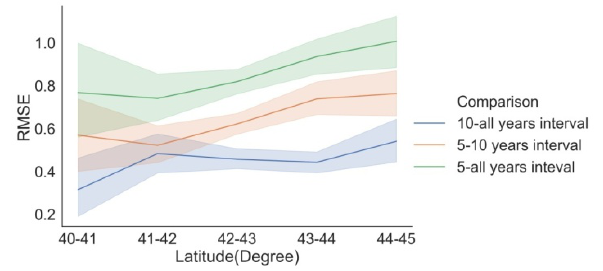
Figure 4. RMSE results in different time intervals Mean absolute difference (MAD) results in 5-10 years interval in Closed Shrublands during 41° and 42° had the minimum value with 1.65 days. MAD results in 5-all years interval in Mixed Forests during 44° and 45° had the maximum value with 9.57 days. Areas with MAD results less than 5 days accounted for 53.3% of all areas, and areas with MAD results less than 3 days accounted for 15.3% of all areas. Area with single functional structure and lower latitude had smaller difference in MAD results in different time intervals.